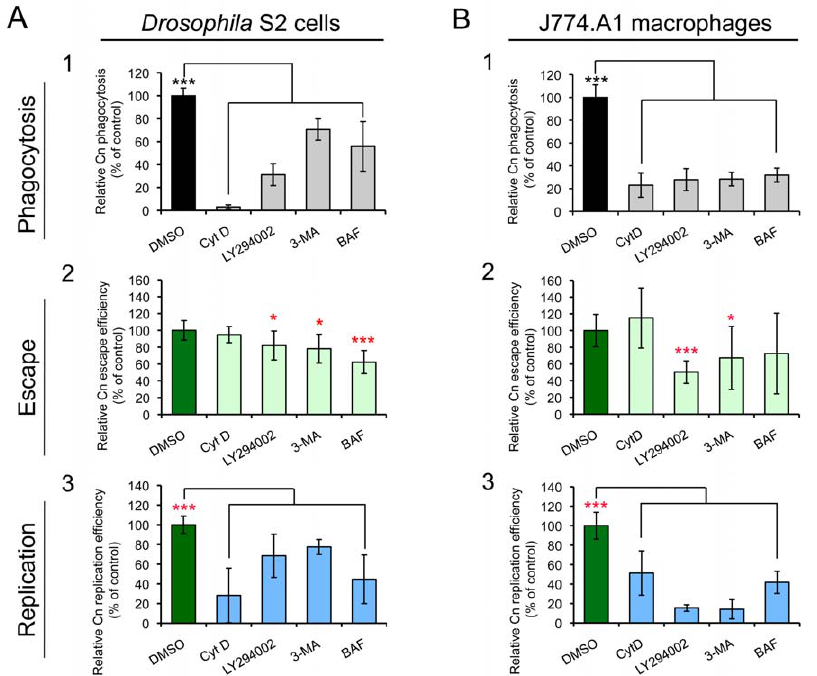
Figure 5. Effect of selected compounds on Cryptococcusneoformans infection. Drosophila S2 cells ( A ) and murine J774.A1 macrophages ( B ) were coincubated with the indicated compounds for 1 hr at the concentrations shown in Table S2. Next, Cn cells were added to the compound- treated host cells and incubated (in the presence of compound) for 3 hrs. The infected host cells were then extensively washed to remove the extracellular population of Cn cells, and new media containing fresh compounds and fluconazole (20 m g/ml) were added. Phagocytosis of Cn cells by host cells ( A1 and B1 ) was determined at 3 h.p.i. by lysing the infected cells, plating the cell lysate on YPD solid medium, and determining the CFUs present after 24 hr incubation at 37 u C. Finally, at 12 h.p.i., the escape ( A2 and B2 ) or intracellular replication ( A3 and B3 ) efficiencies of Cn cells were measured separately as described in the Materials and Methods section. *, **, *** indicates significance at P , 0.05, 0.01 and 0.001, respectively, compared with the DMSO treated control. CytD, 3-MA and BAF indicate that host cells were treated with cytochalasin D, 3-Methyladenine and bafilomycin A1, respectively. Data represent the means 6 standard deviations from at least three independent experiments.